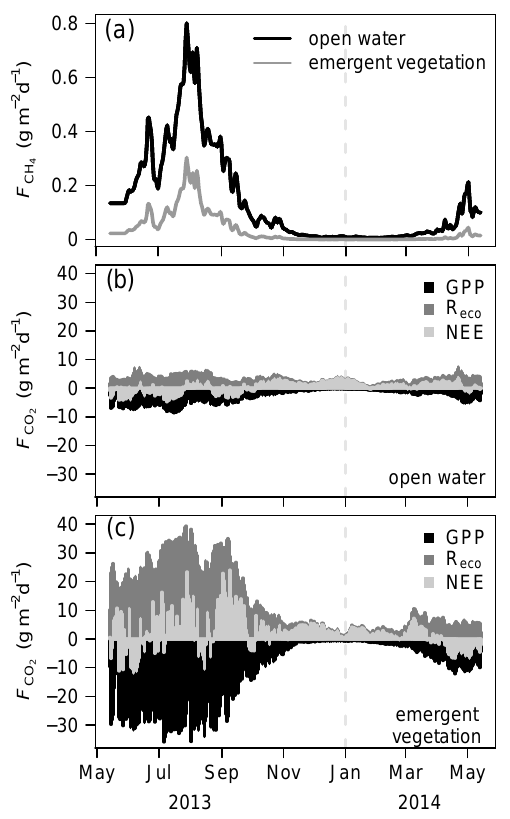
Figure 7. Daily CH 4 , NEE and component fluxes ( R eco and GPP) for the surface types: (a) daily CH 4 flux of open water and emer- gent vegetation; (b) daily NEE and component fluxes for open wa- ter; (c) daily NEE and component fluxes for emergent vegetation, derived by NLR with the source area fractions of the surface types ) ( (cid:127) i ) as weighting factors (NLR CH , NLR CO 4 foot 2 foot